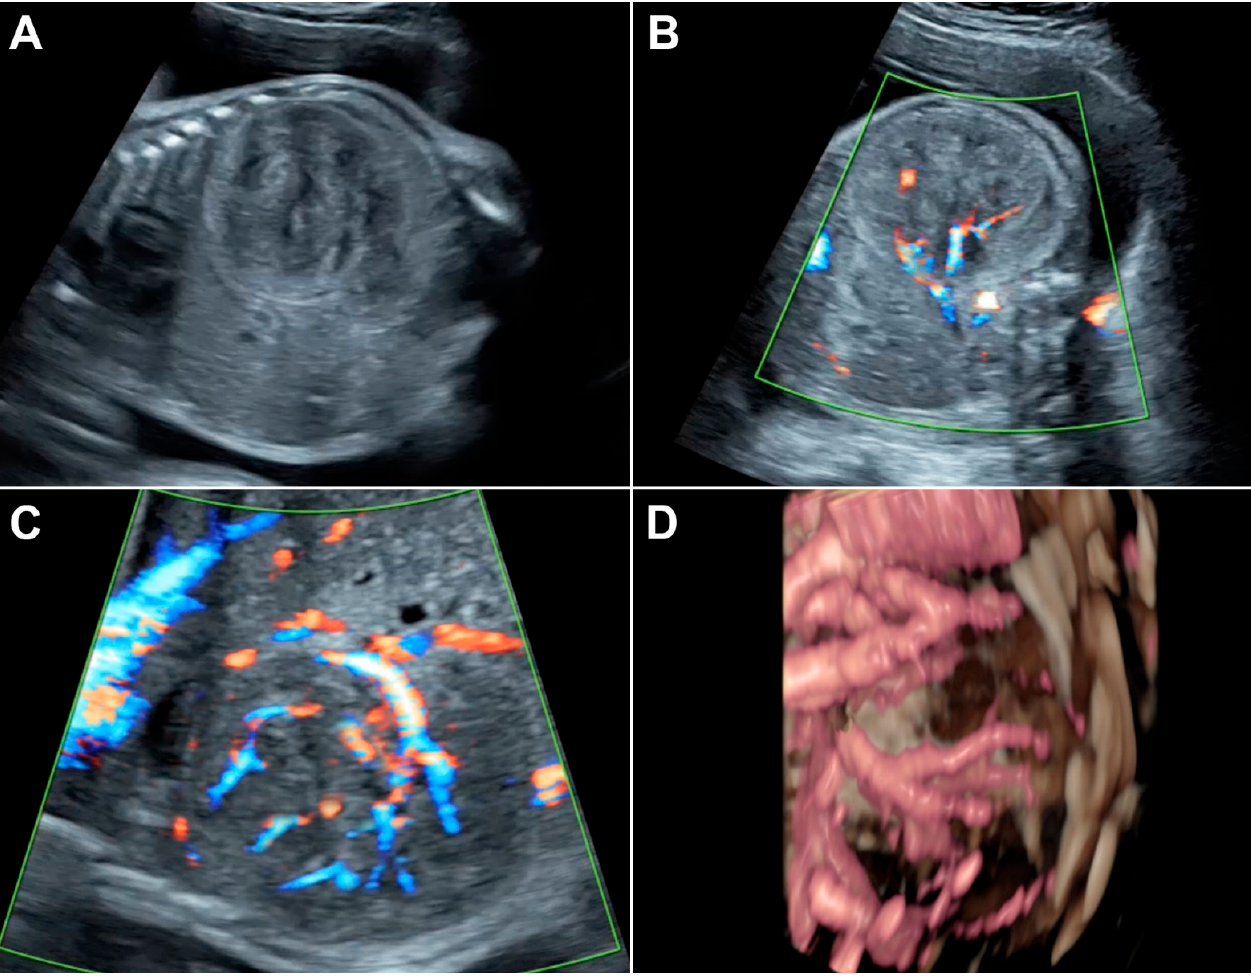
Figure 1. Prenatal ultrasound of the renal mass (congenital mesoblastic nephroma). ( A ) Coronal scan of the fetal trunk shows a well-demarcated, heterogeneous solid mass; ( B ) cross-section of the fetal abdomen shows the same mass; ( C ) color-flow mapping of the mass shows strong vascularization; ( D ) color-flow 3D ultrasound shows strong vascularization.